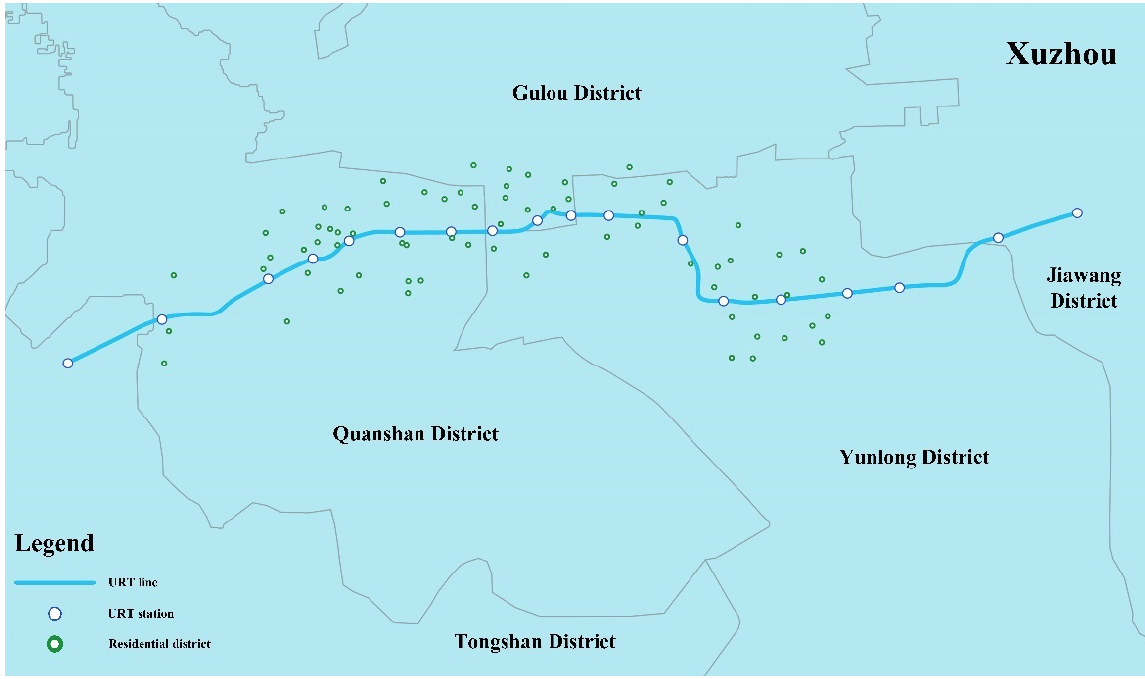
Figure 3. The geographic location of Xuzhou.